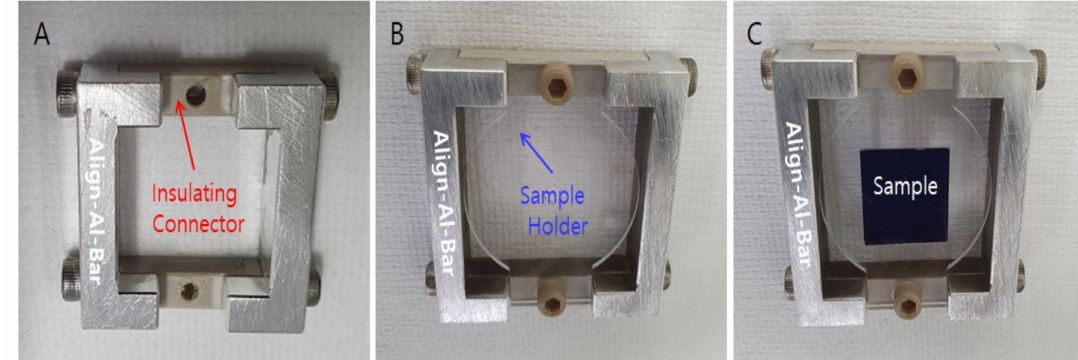
Figure 3. Alignment jig used in the electrospinning process for parallel (uniaxial) alignment of electrospun fibers. ( A ) Optical image of the alignment jig without sample and sample holder. ( B ) Optical image of the alignment jig with sample holder. ( C ) Optical image of the alignment jig with sample and sample